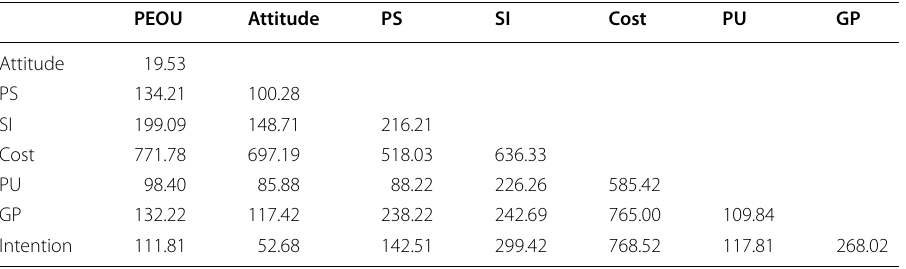
Table 3 Discriminant validity